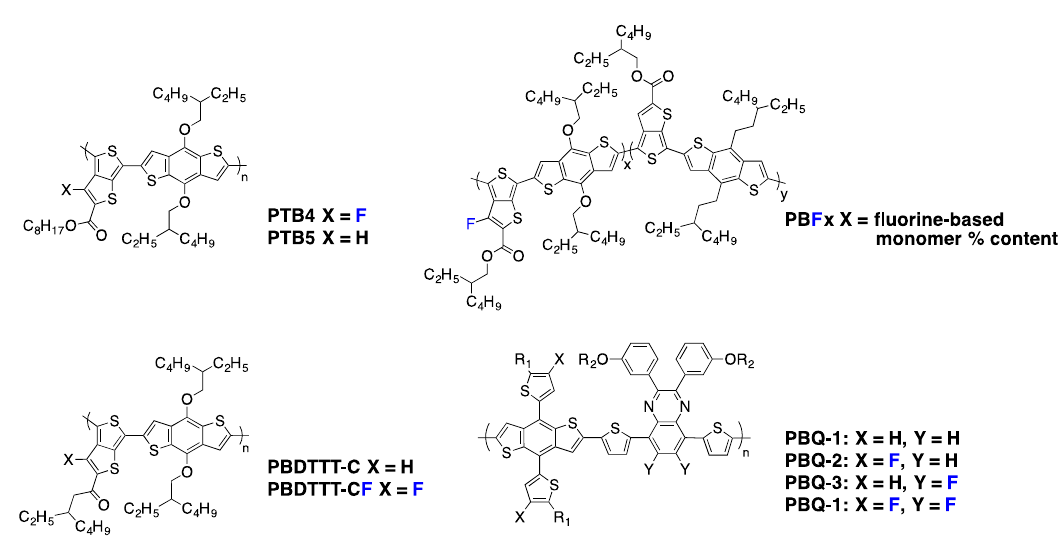
Figure 3. Chemical structures of some investigated polymers. Table 2. FMO energy levels and band-gap values of some investigated polymers.